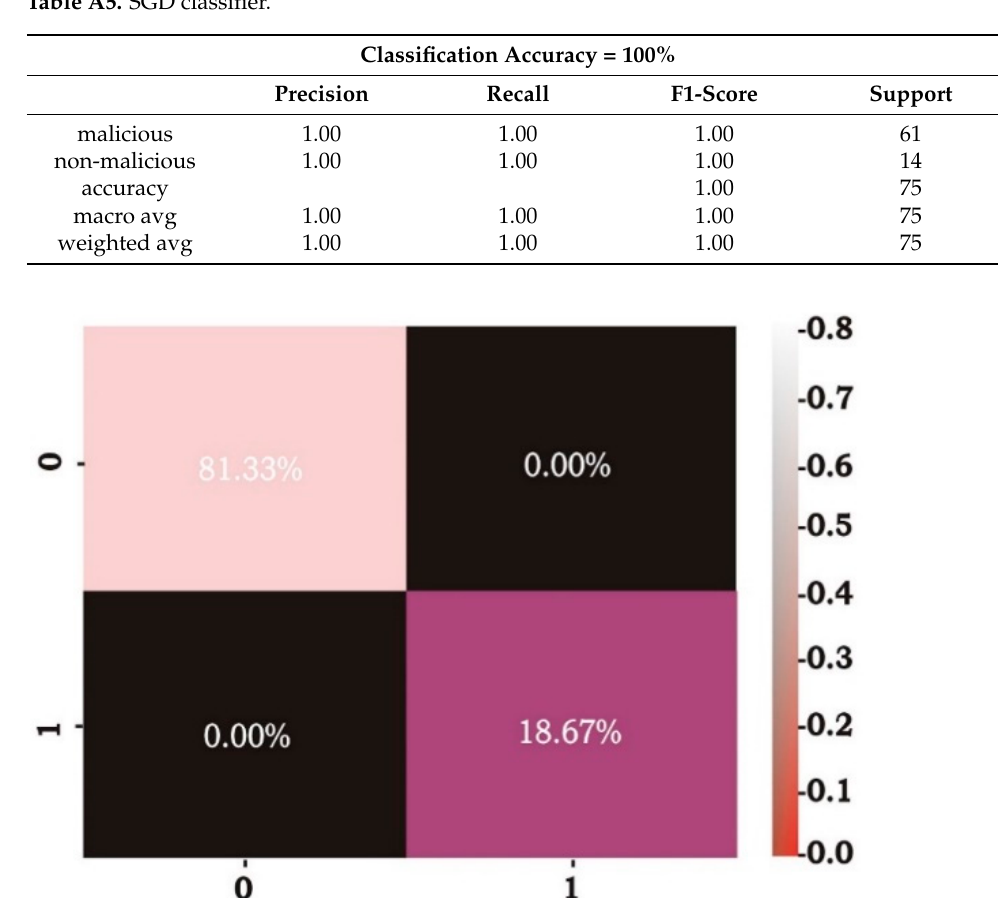
Table A5. SGD classifier.